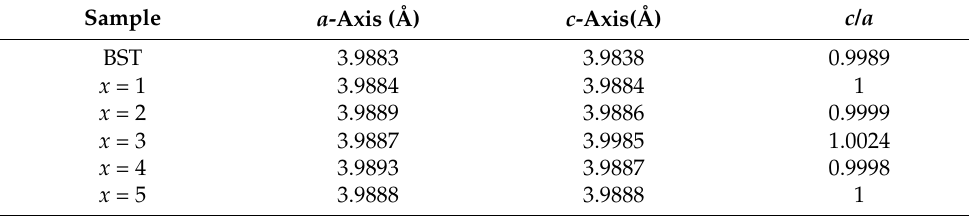
Figure. 2 is a transmission morphology diagram of BST-2 mol% MgO ceramic